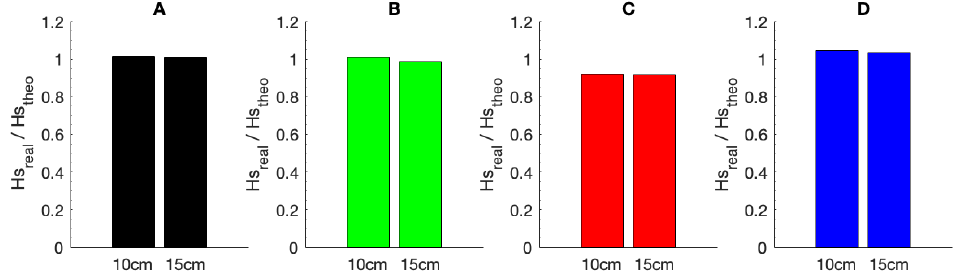
Figure 14. Ratio of realised ( H s T p = 1.81 s, Hs = 10 cm, and 15 cm sea-states for facilities ( A – D ).